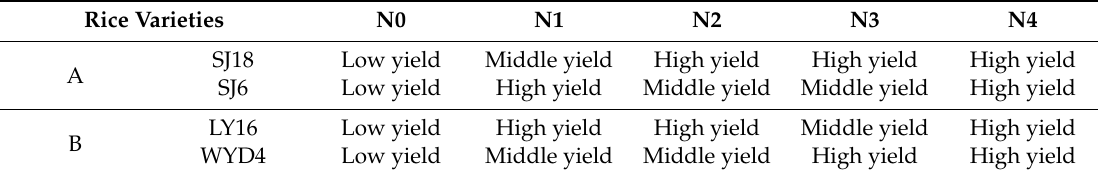
Table 4. Results of the yield division of the different rice varieties.